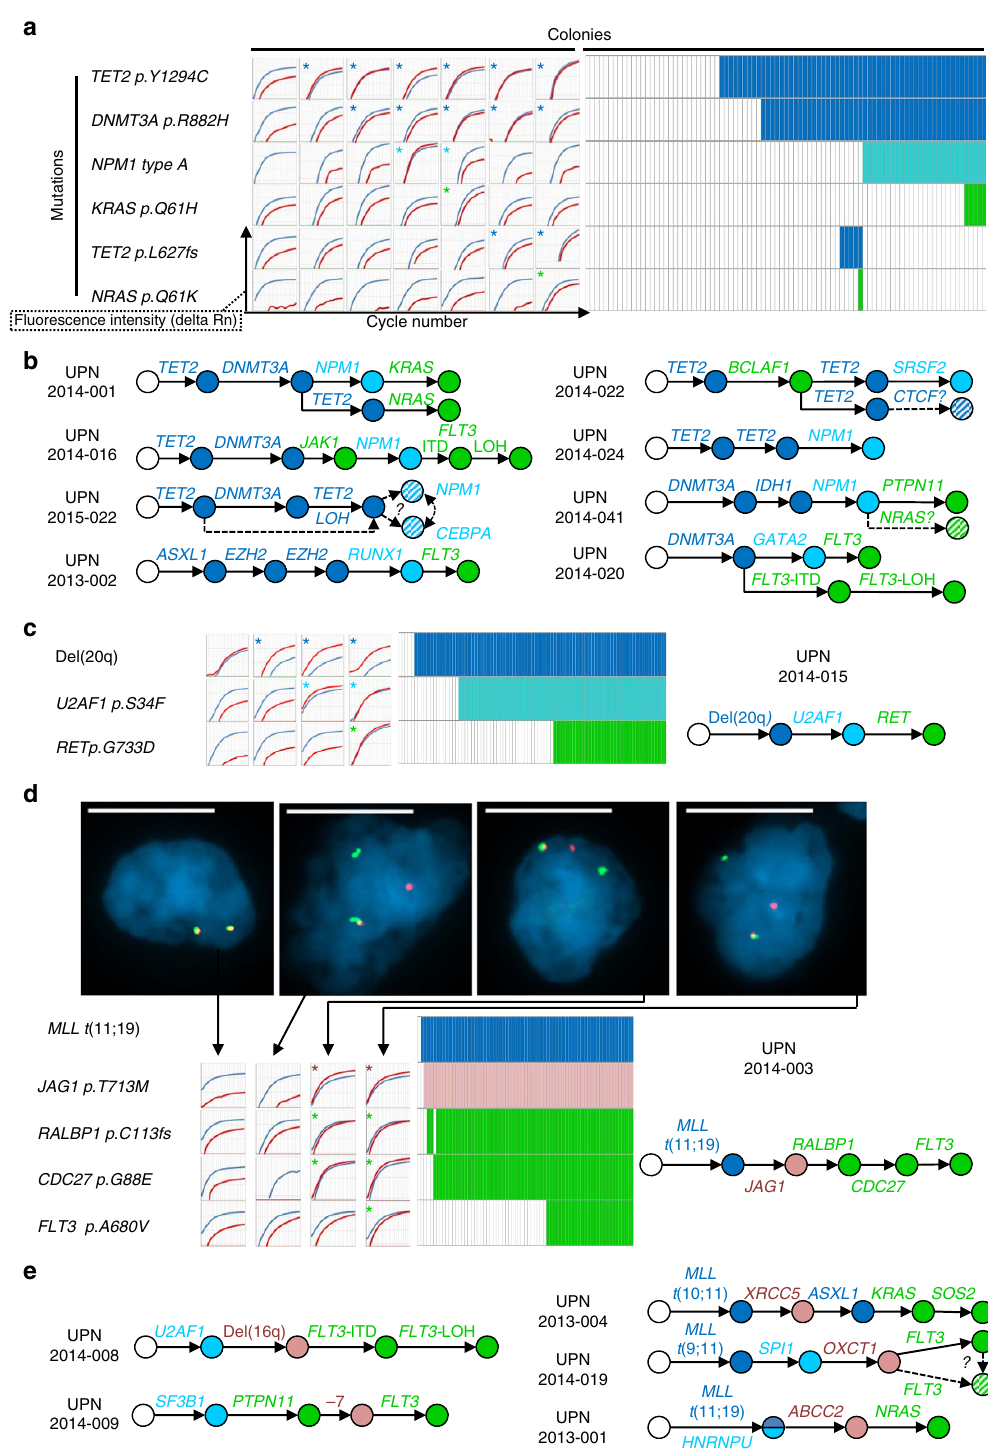
Figure 1 | Single-cell-derived colony analysis identifies a recurrent order of acquisition of AML mutations and chromosomal rearrangements. ( a ) Left panel: allele specific (AS) PCR amplification plots of mutant (red) and wild type (blue) alleles in seven colonies from patient UPN2014-001. Asterisks indicate mutant allele detection. Right panel: results of AS assays (rows) in 87 colonies (columns). Mutant colonies are indicated by coloured boxes. Blue: lesions in epigenetic regulators; cyan: lesions involving NPM1 , transcription or splicing factors; green: proliferative lesions; pink: other lesions. ( b ) Mutation order in eight patients with normal karyotype AML. Dashed arrows and hatched circles indicate positions that could not be determined. ( c ) Analysis of 85 colonies from patient UPN2014-015 as in a . To detect del(20q), an informative single-nucleotide polymorphism (SNP)(rs11556379) was used. The inferred order of lesions is shown. ( d ) Genotyping analyses, as in a , and FISH analyses of colonies from patient UPN2014-003. Dissociations of the red and green signals indicate MLL rearrangements. Nuclei were stained with 4,6-diamidino-2-phenylindole. Bars indicate 10 m m. Right panel: results of FISH and AS assays, as in a . The inferred order of lesions is shown. ( e ) Order of lesions in five additional abnormal karyotype